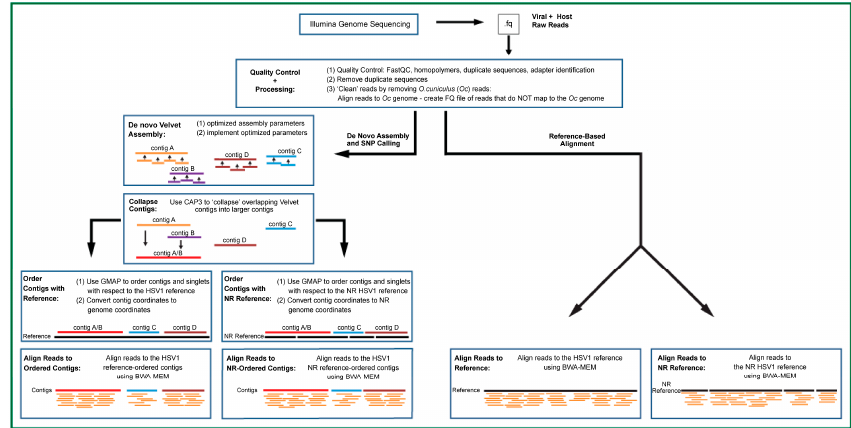
Figure 1. Strategies for individual viral sequencing: a comparison of reference-based versus de novo assembly and alignments for downstream variant calling. FASTQ files contain read sequences for both herpes simplex virus (HSV) 1 and the rabbit ( Oryctolagus cuniculus , ( Oc )) skin cell line used to propagate the virus. Read quality was evaluated, and reads were aligned to the O. cuniculus reference to remove the host reads. (Left side) Reads were assembled de novo using Velvet to create contigs and CAP3 to collapse overlapping Velvet contigs into longer contigs. In preparation for variant calling, contigs were aligned to the full-length HSV1 reference (GenBank Accession Number: NC_001806) and the HSV1 non-redundant (NR)-reference (Supplementary File 1). The set of putative HSV1 reads used to create the contigs was aligned to the contigs. (Right side) Reads were aligned to the full-length HSV1 (GenBank Accession Number: NC_001806) reference and the HSV1 NR-reference (Supplementary File 1). BWA-MEM: Burrows-Wheeler Aligner; GMAP: Genomic mapping